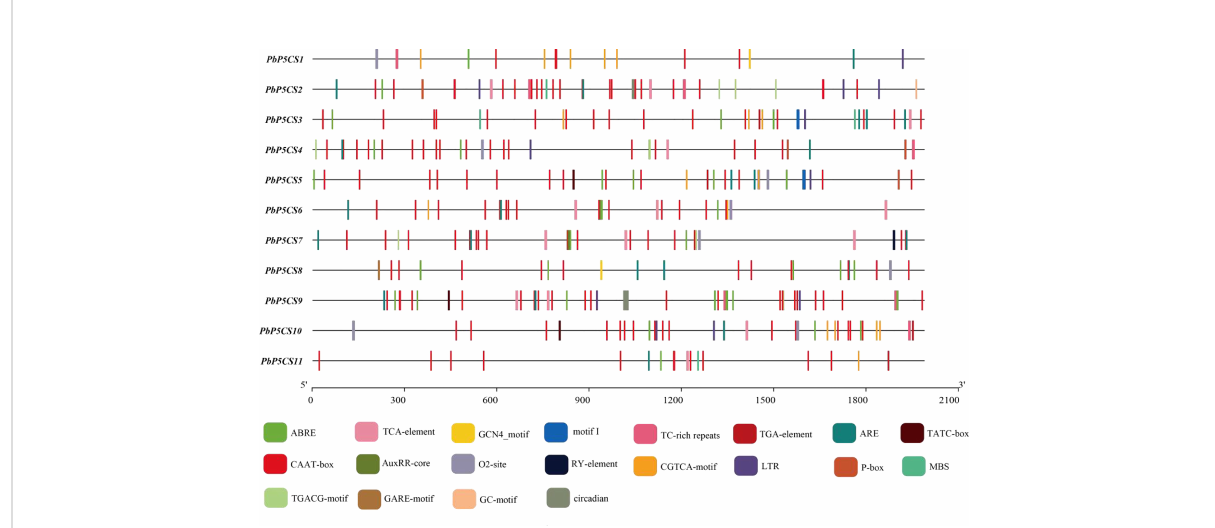
FIGURE 5 Promoter cis-regulatory element analysis of PbP5CS genes. Different colors indicate various promoter elements in PbP5CS genes.